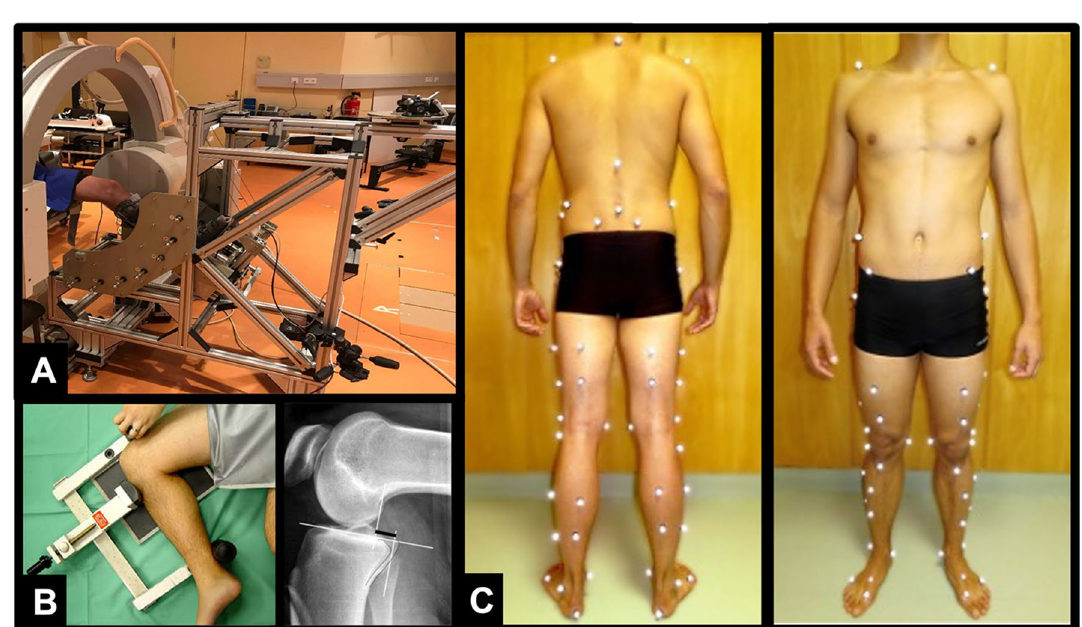
Figure 1. Measurement setup to assess passive knee joint rotation ( A ), passive posterior translation with stress radiography ( B ), and marker set of motion gait analysis to determine in-gait knee joint rotation and translation ( C